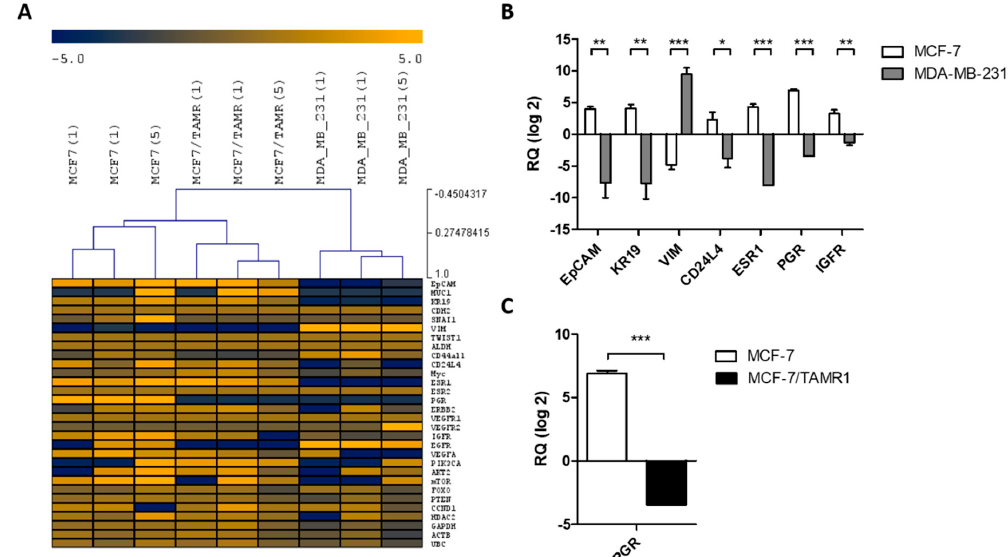
Figure 2. Gene expression of single cells and pools of isolated cell line cells. ( A ) Dendrogram and heat map analyses of Cq measurements of single MCF-7, MCF-7/TAMR1, and MDA-MB-231 cells ( n = 2 per cell line) and pools of five cells ( n = 1). Each gene is measured in triplicate. Data are mean centered, with mean expression responses to zero. Yellow indicates high expression and blue color represents downregulation relative to the mean of the pool. ( B ) Bar graph showing significant differences in transcript expression between MCF-7 and MDA-MB-231 cells (*, p < 0.05, ** p < 0.01, *** p < 0.001). ( C ) Bar graph showing significant differences in transcript expression between MCF-7 and MCF-7/TAMR1 cells (*** p < 0.001).